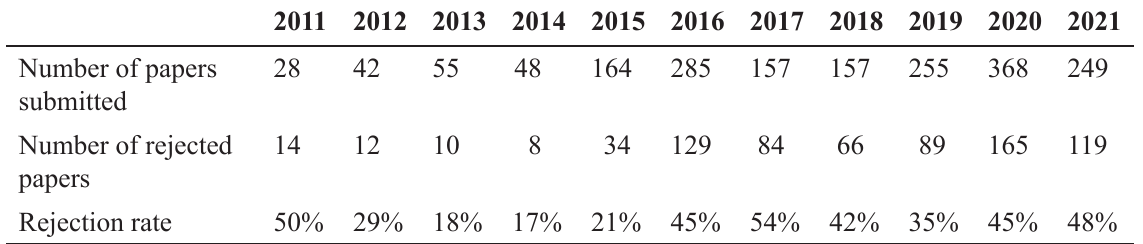
Table 6. Number of submitted papers vs rejected papers from 2011 up to 9 th Sept.